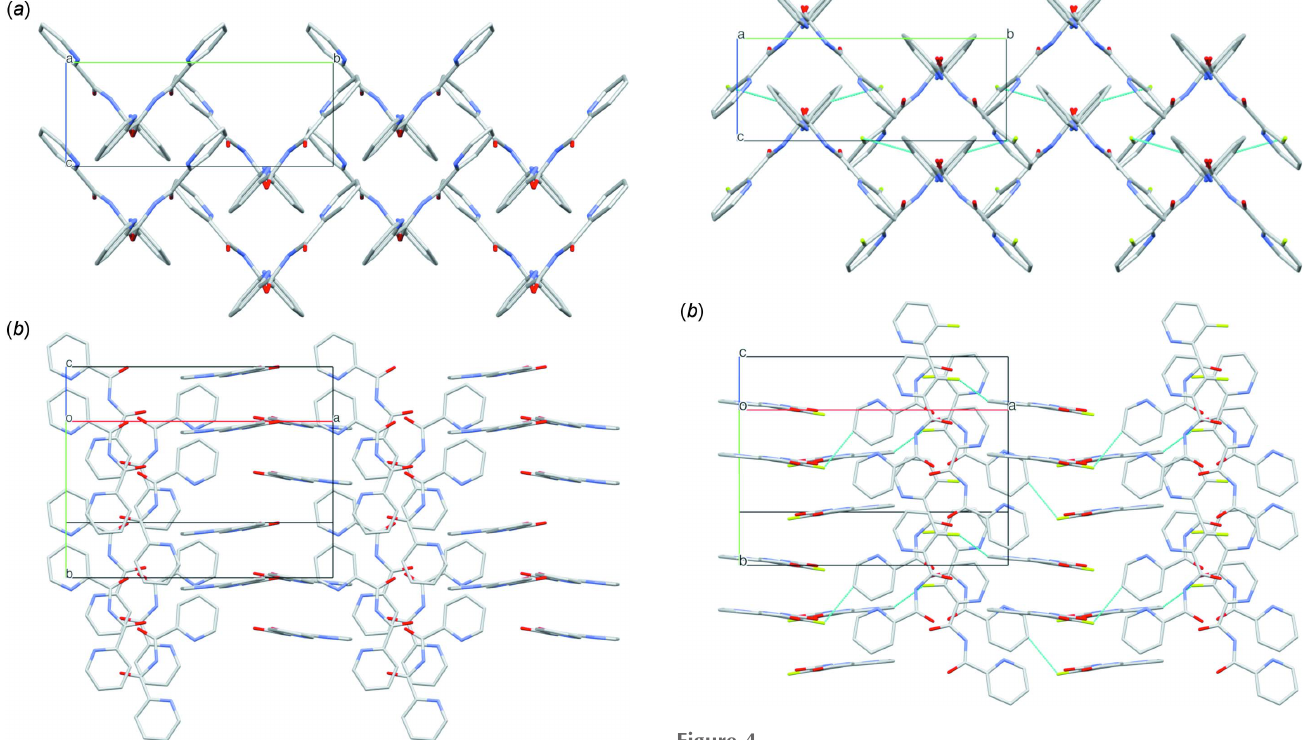
Figure 4 Packing in the structure of 2 , showing ( a ) the perpendicularly oriented molecules, viewed down the a axis and ( b ) the double layers of parallel- oriented (face-to-face) molecules, interchanged with analogous double layers, perpendicular to the former layers. C10—H10 (cid:4)(cid:4)(cid:4) F1 A hydrogen bonds are indicated. Hydrogen atoms and disorder of the fluorine atoms are omitted for clarity.